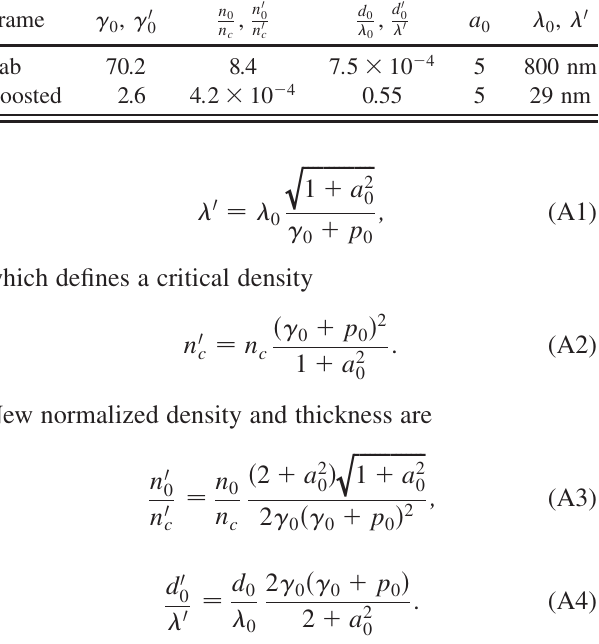
TABLE I. Simulation parameters of Fig. 2 in both lab and boosted frames.